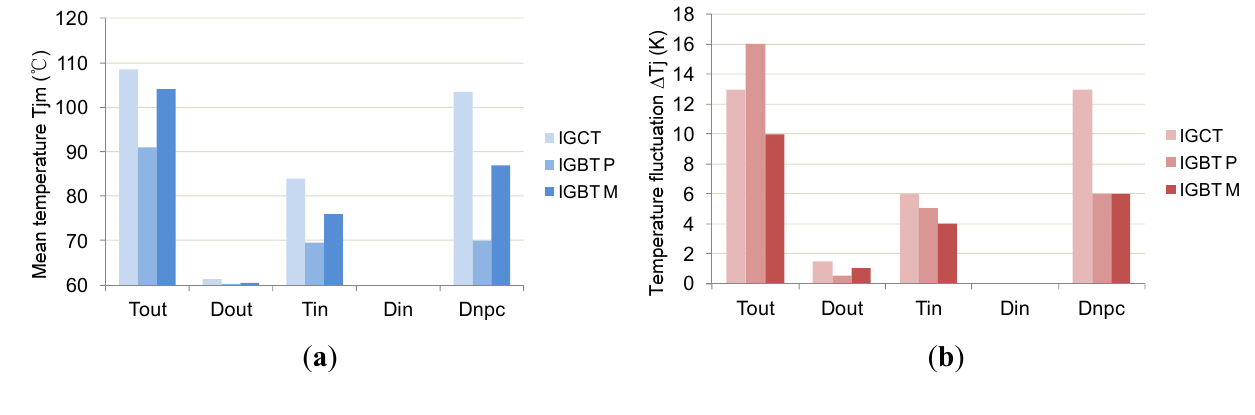
Figure 12. Thermal cycling profile of the 3L-NPC inverter with different switching device solutions under normal operation ( V = 1 p.u., PF = 1, v = 12 m/s). ( a ) Mean junction g w temperature T and ( b ) Junction temperature fluctuation Δ T jm j.